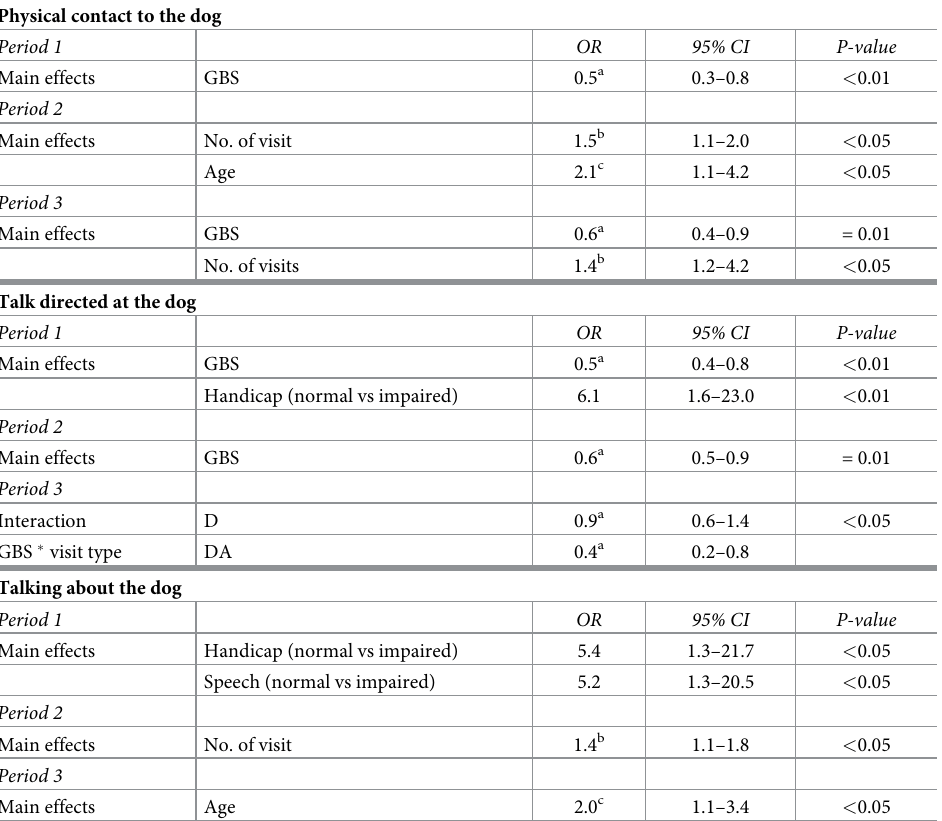
Table 7. Results from the analysis of behaviour related to the dog in the first two minutes of D and DA visits. Physical contact to the